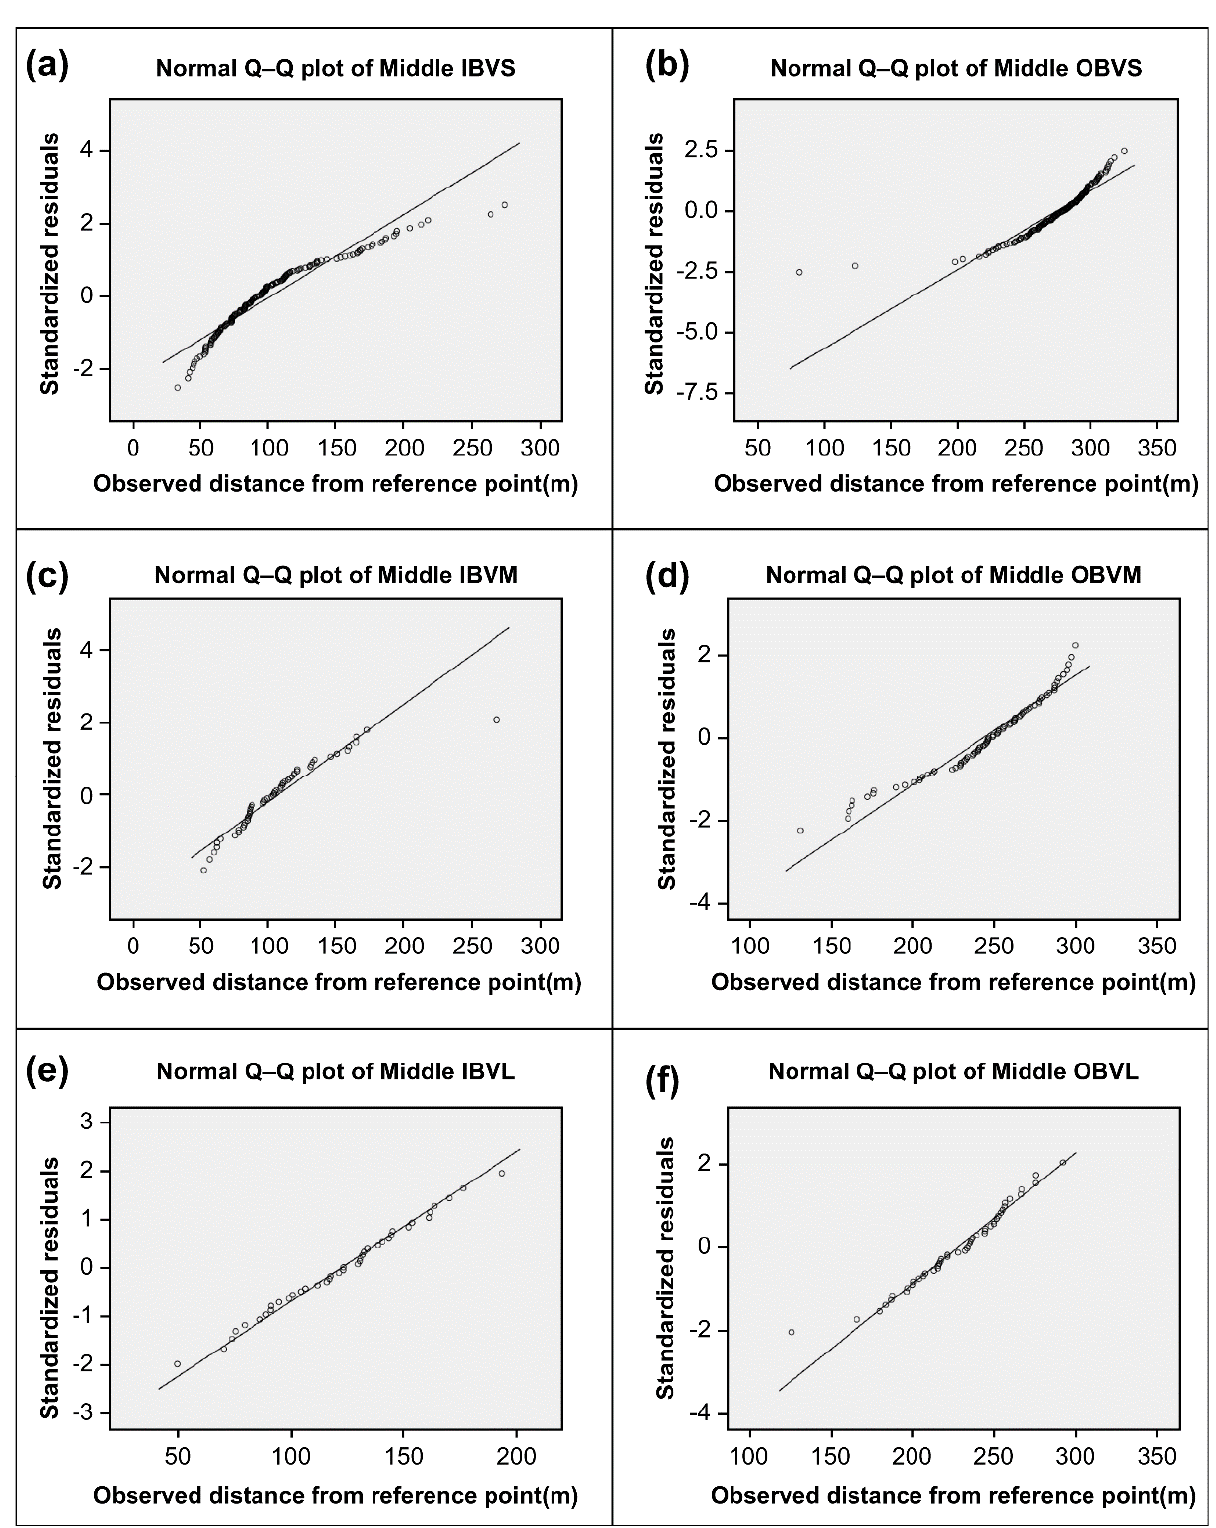
Figure A2. Normal Q–Q plot of the middle part: ( a ) small IBVs, ( b ) small OBVs, ( c ) mid-sized IBVs, ( d ) mid-sized OBVs, ( e ) large IBVs, and ( f ) large OBVs.